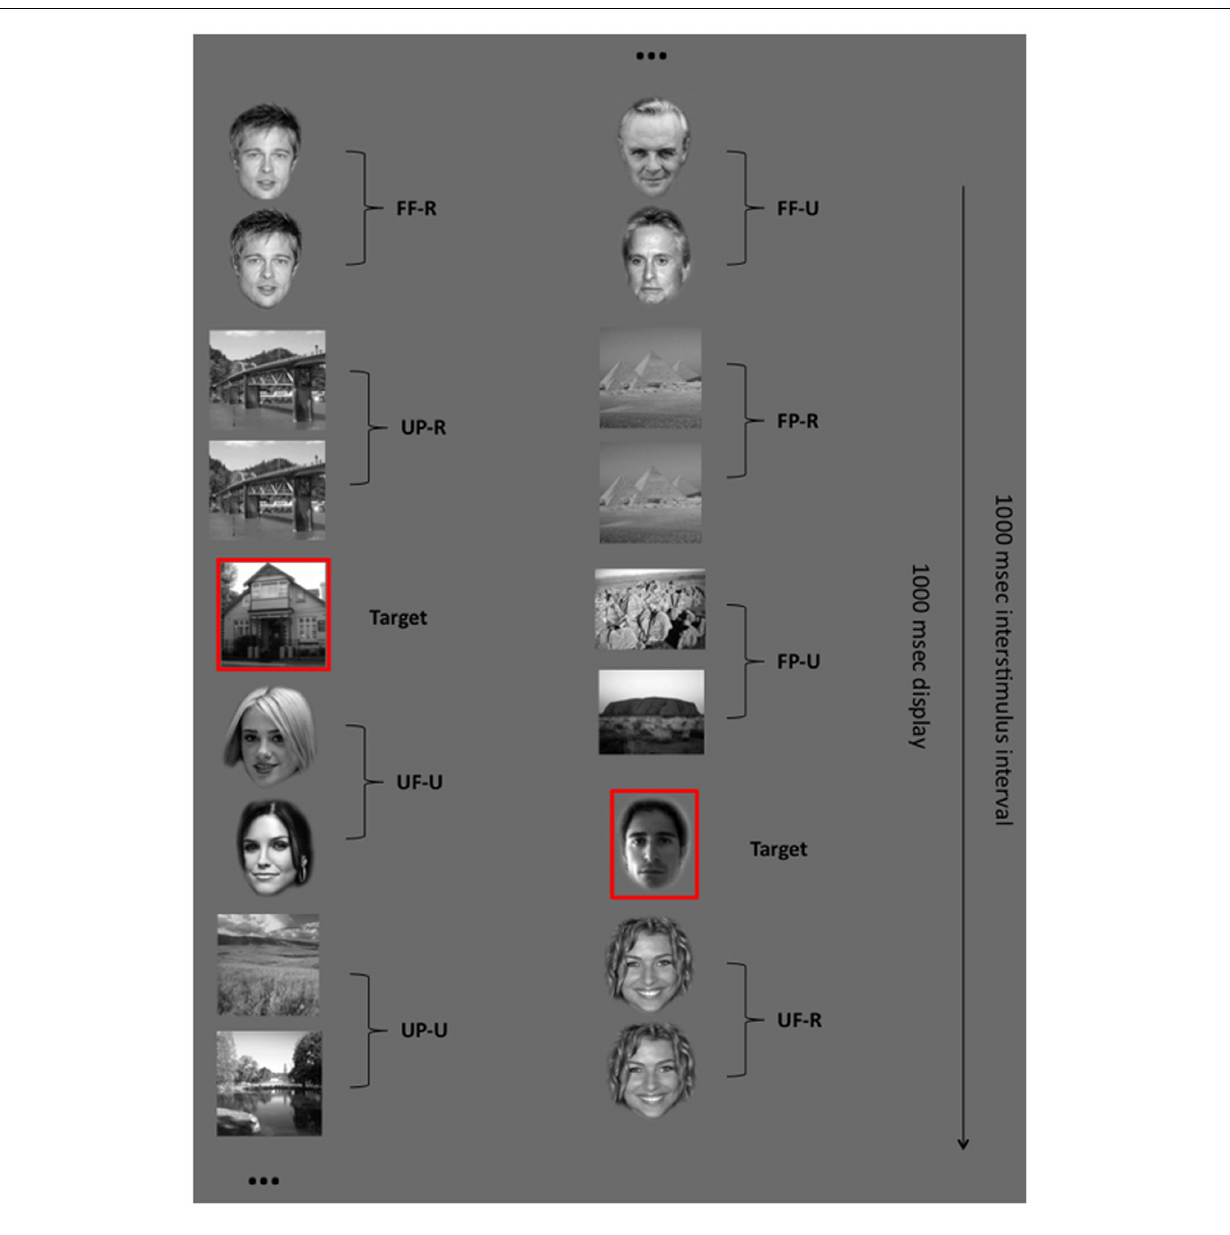
FIGURE 1 | Experimental design. Participants had to press a button whenever they saw a previously selected target (either a face or a place). Stimuli were shown in pairs. Each pair consisted of faces or places. Both faces and places could be familiar or unfamiliar as well as repeated or unrepeated (FF-R: familiar face repeated; FF-U: familiar face unrepeated; UF-R: